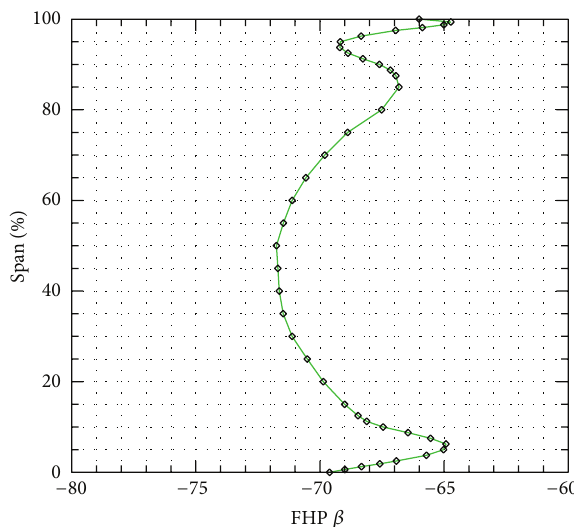
Figure 22: Mass averaged FHP measured yaw ( 𝛽 ) angle, intraspace.